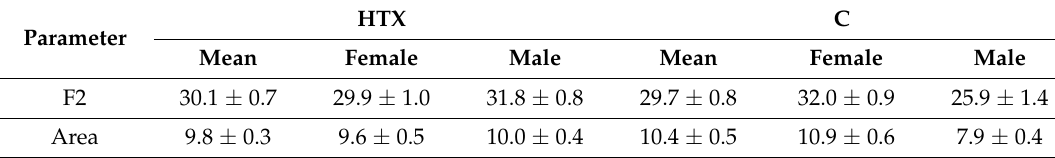
Table 4. Fetal muscle fibers at day of sampling (Day 100 of pregnancy). Mean values ( ± SEM) and differences for sexes for the number of secondary fibers (F2) and the area of the muscle fiber in treated (Hydroxytyrosol; Group HTX) and control fetuses (Group C).